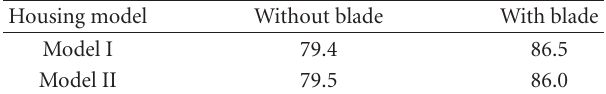
Figure 15: Static pressure contour at the blade section H (Pa, r = 0 . 2805m).